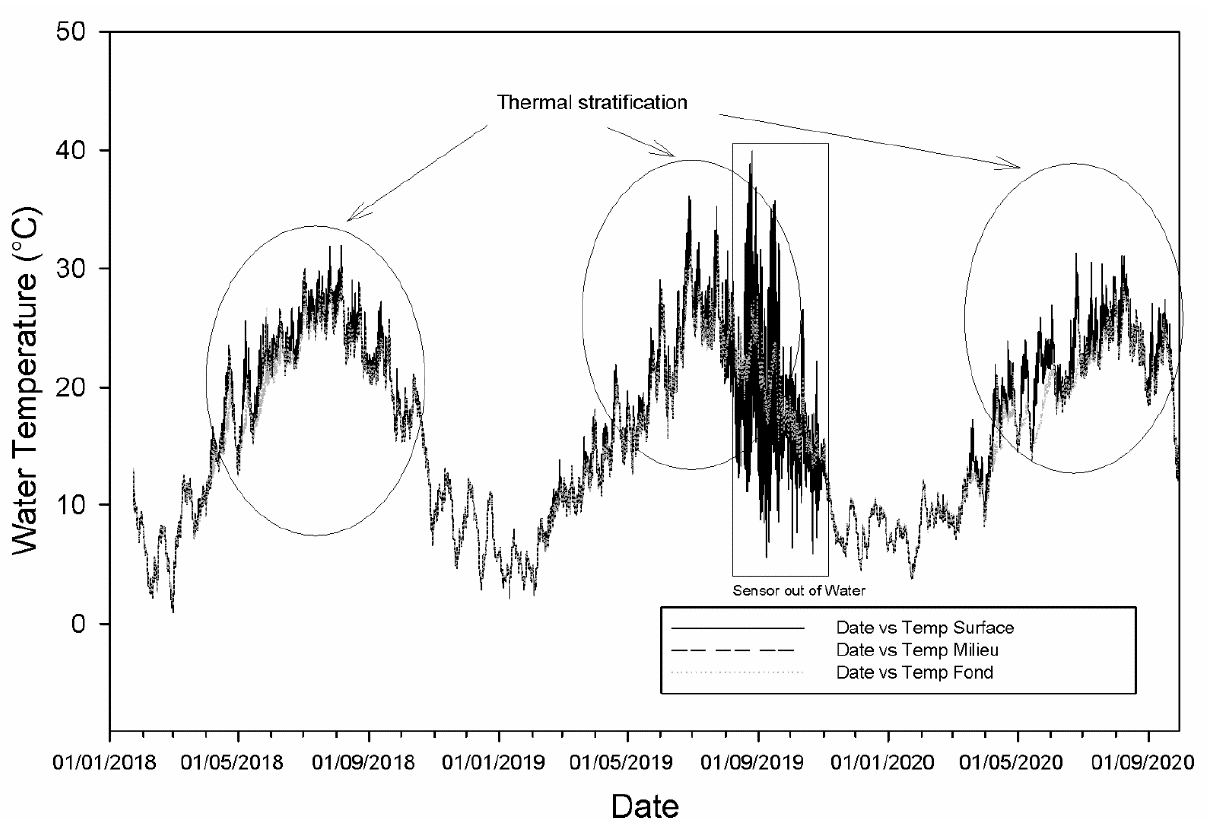
Figure 3. Changes in water temperatures between 2018 and 2020 at Thomas Pond.